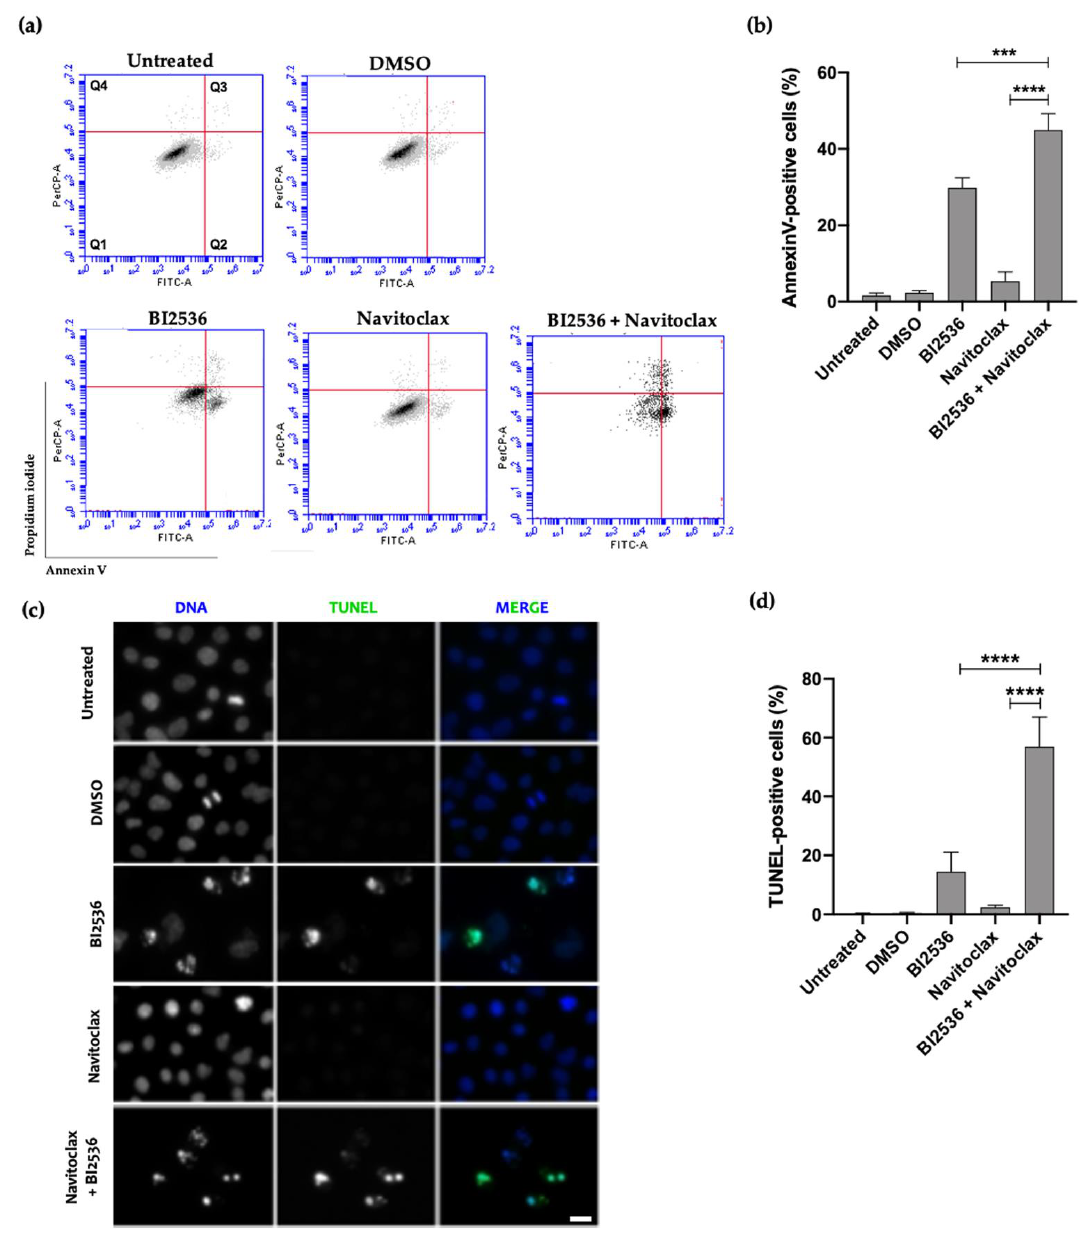
Figure 5. Combination of BI2536 and Navitoclax potentiates cancer cell death by apoptosis. ( a , b ) Flow cytometry analysis of apoptosis, in A549 cell line, by Annexin V/PI co-staining, after 48 h treat- ment. The quadrants Q were defined as Q1 = live (Annexin V- and PI-negative), Q2 = early stage of apoptosis (Annexin V-positive/PI-negative), Q3 = late stage of apoptosis (Annexin V- and PI-posi- tive), and Q4 = necrosis (Annexin V-negative/PI-positive). ( b , d ) Quantification of A549 ( b ) Annexin V-positive cells are shown with statistical relevance of *** p < 0.001 and **** p < 0.0001 by one-way ANOVA with Tukey’s multiple comparisons test. ( c ) Representative images of A549 apoptotic cells after 48 hours’ treatment, revealed by TUNEL assay to detect DNA fragmentation (green). DNA (blue) was stained with DAPI. Bar, 5 µm. ( d ) Quantification of A549 TUNEL-positive cells. **** p <